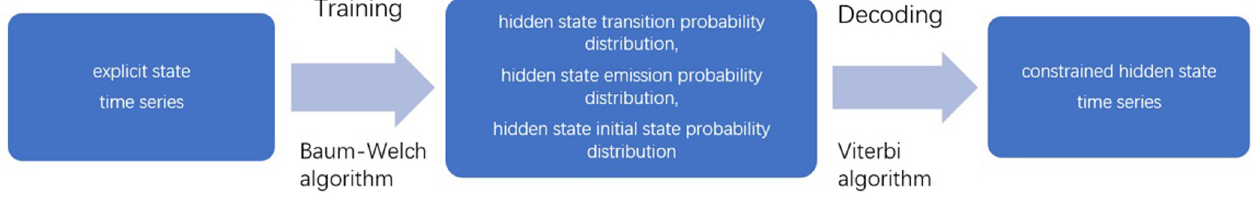
PLOS ONE | https://doi.org/10.1371/journal.pone.0253845 July 26,